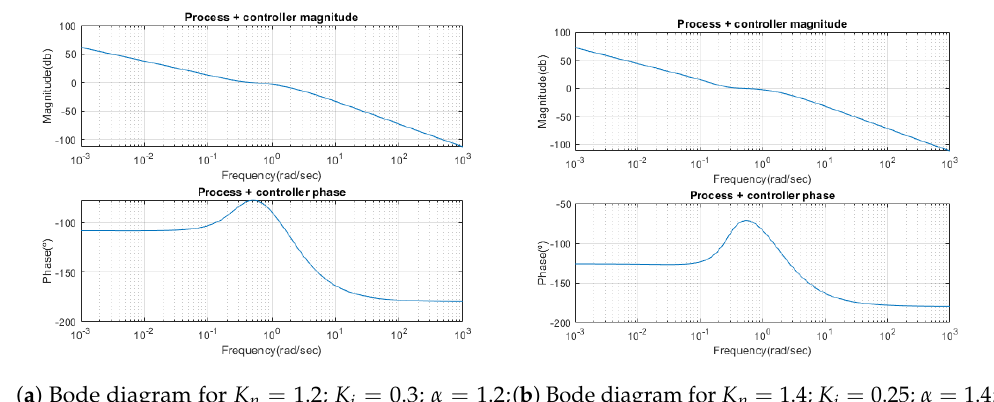
Figure 7. Bode plot of the system with different